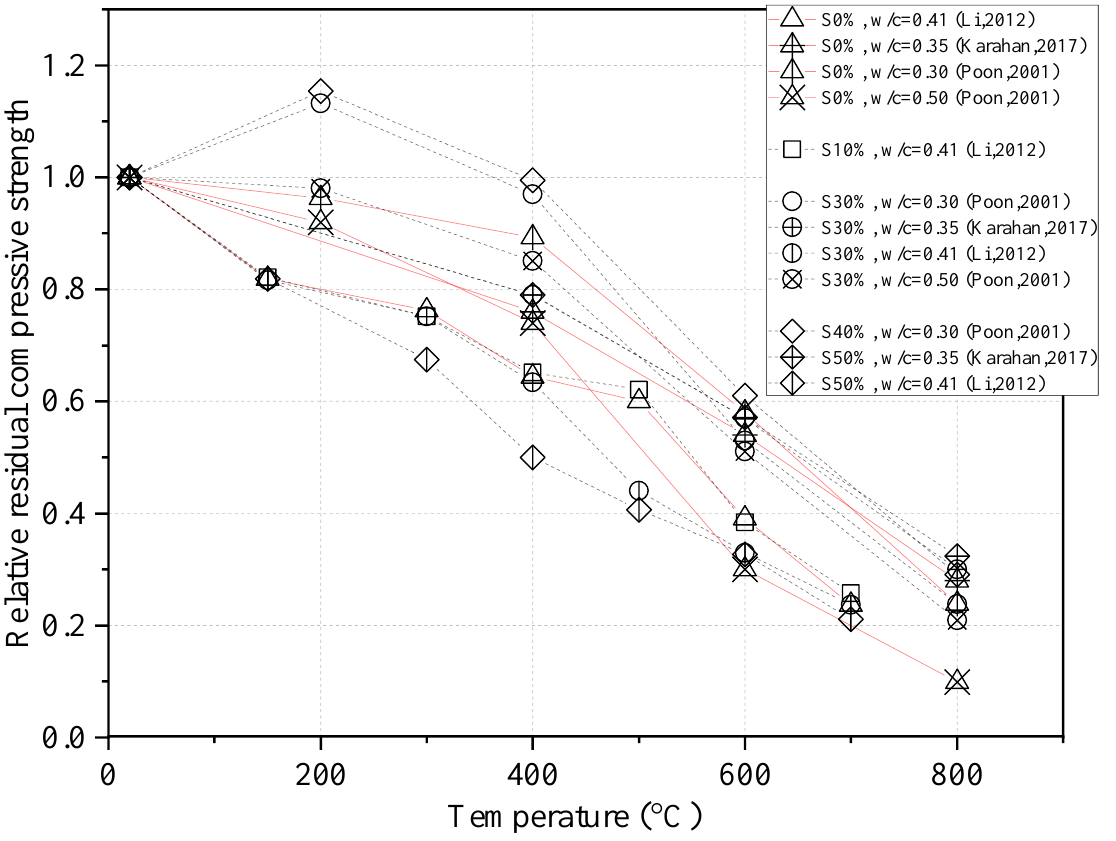
Figure 9. The residual compressive strength of concrete containing slag (S) at different water-to- cementitious materials ratios (w/c) [35,39,45].